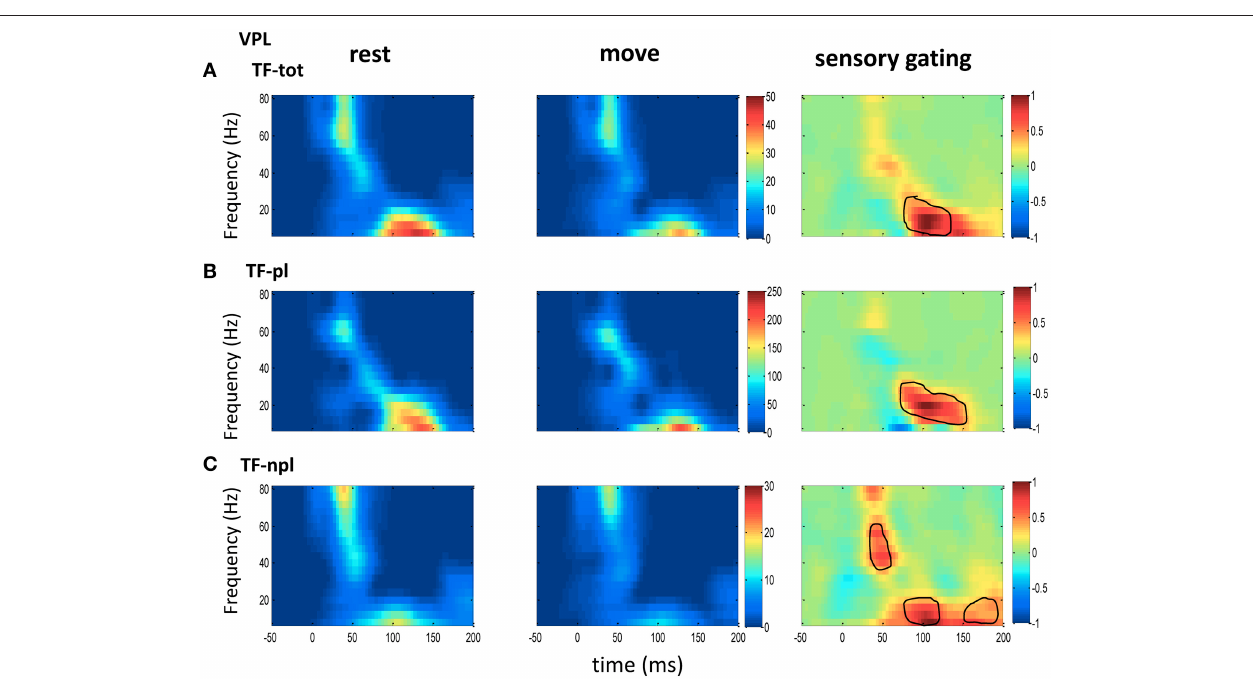
FIGURE 2 | The grand average powers in VPL. (A) Total powers during rest (left) and move (right) show early high gamma oscillations followed by low frequency oscillation. Movement induced sensory gating (right: rest–move) occurs at low frequency bands (right). (B) The phase-locked power, which is time-frequency representation on trial-averaged SEPs, shows similar pattern to that of total power but shifted toward low frequency band. (C) The non-phase-locked power shows stronger oscillation at gamma band than at low frequency band, and sensory gating presents at both gamma band and low frequency band. Colorbar in each map of rest and move condition represents normalized power (std of baseline); Colorbar of the sensory gating map was normalized to maximum value of the map, and elements within circle represent significantly changed ( p < 0.05 for signrank test, n = 10 ).